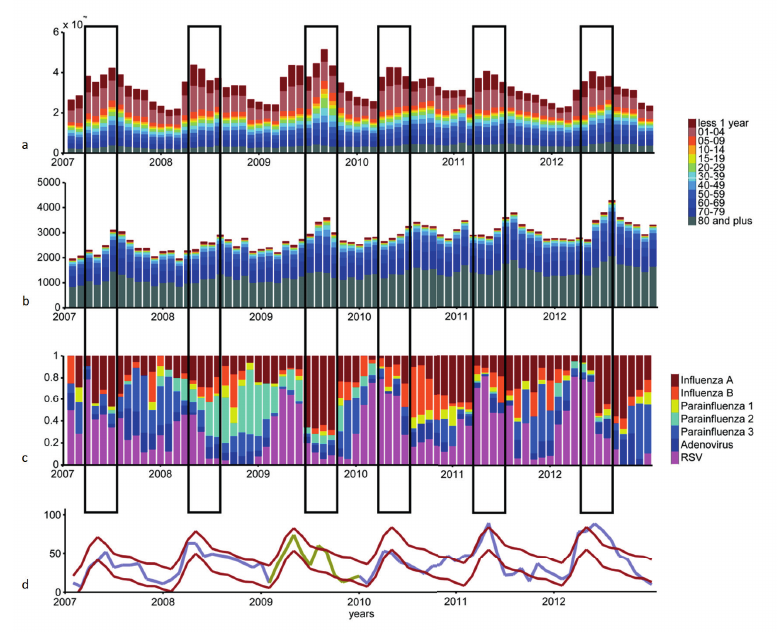
Figure 5. Epidemic monthly series of the “Tropical Midwest and Southeast” zone: (a) Hospitalizations in the public sector, ( b ) deaths, ( c ) proportion of respiratory viruses detected ( d ) total respiratory viruses detected and periodic annual function (PAF, when 2009 is excluded).